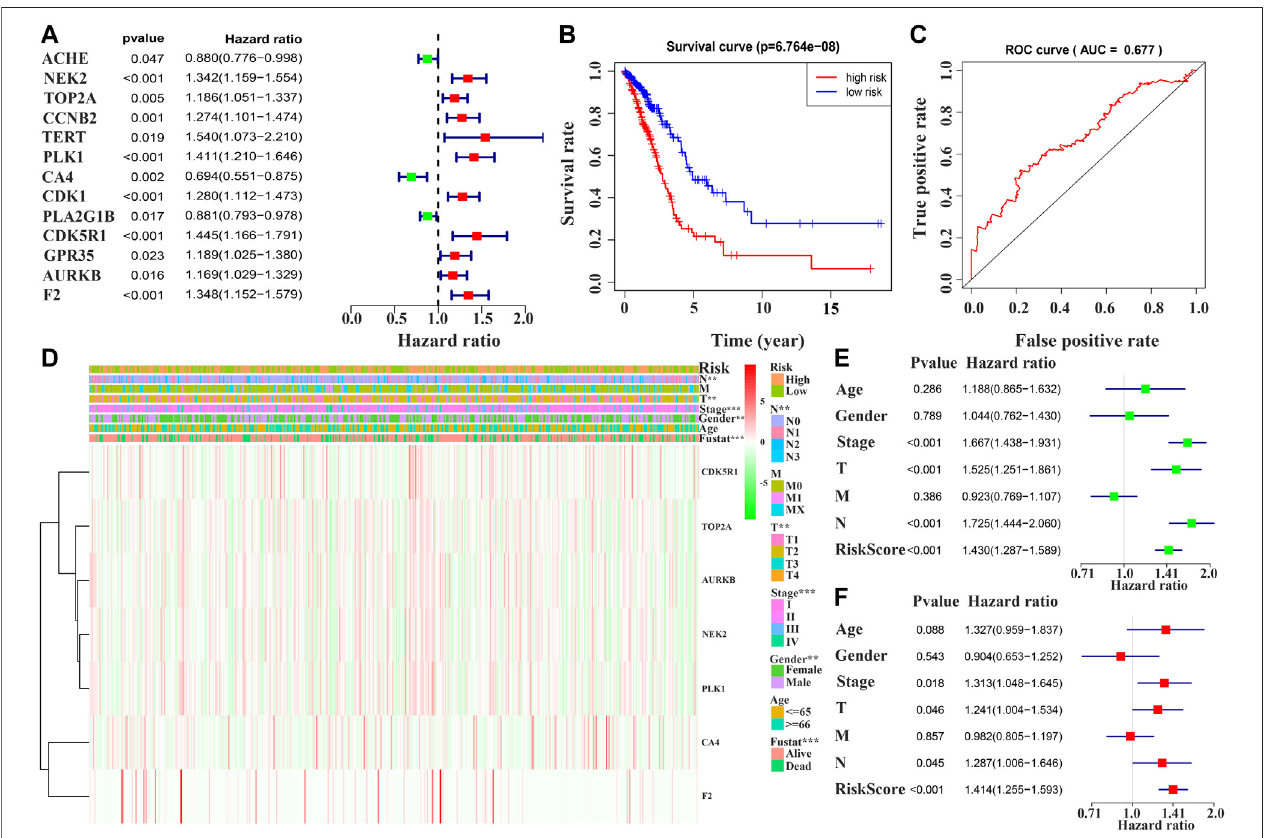
FIGURE 4 | Prognostic value of quercetin-related differentially expressed target genes in patients with LUAD via the COX and survival analysis. Note: LUAD, lung adenocarcinoma.